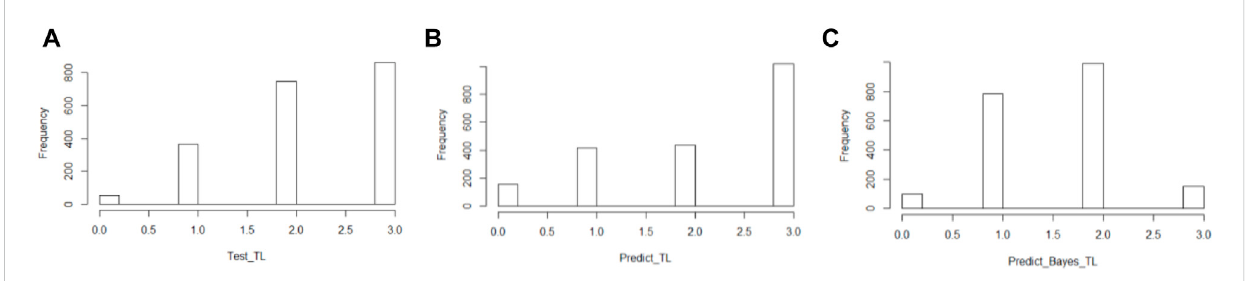
FIGURE 5 Distribution of the therapy length (TL) of the target data (A) , the prediction computed with the baseline model (B) , and the BNNs (C)